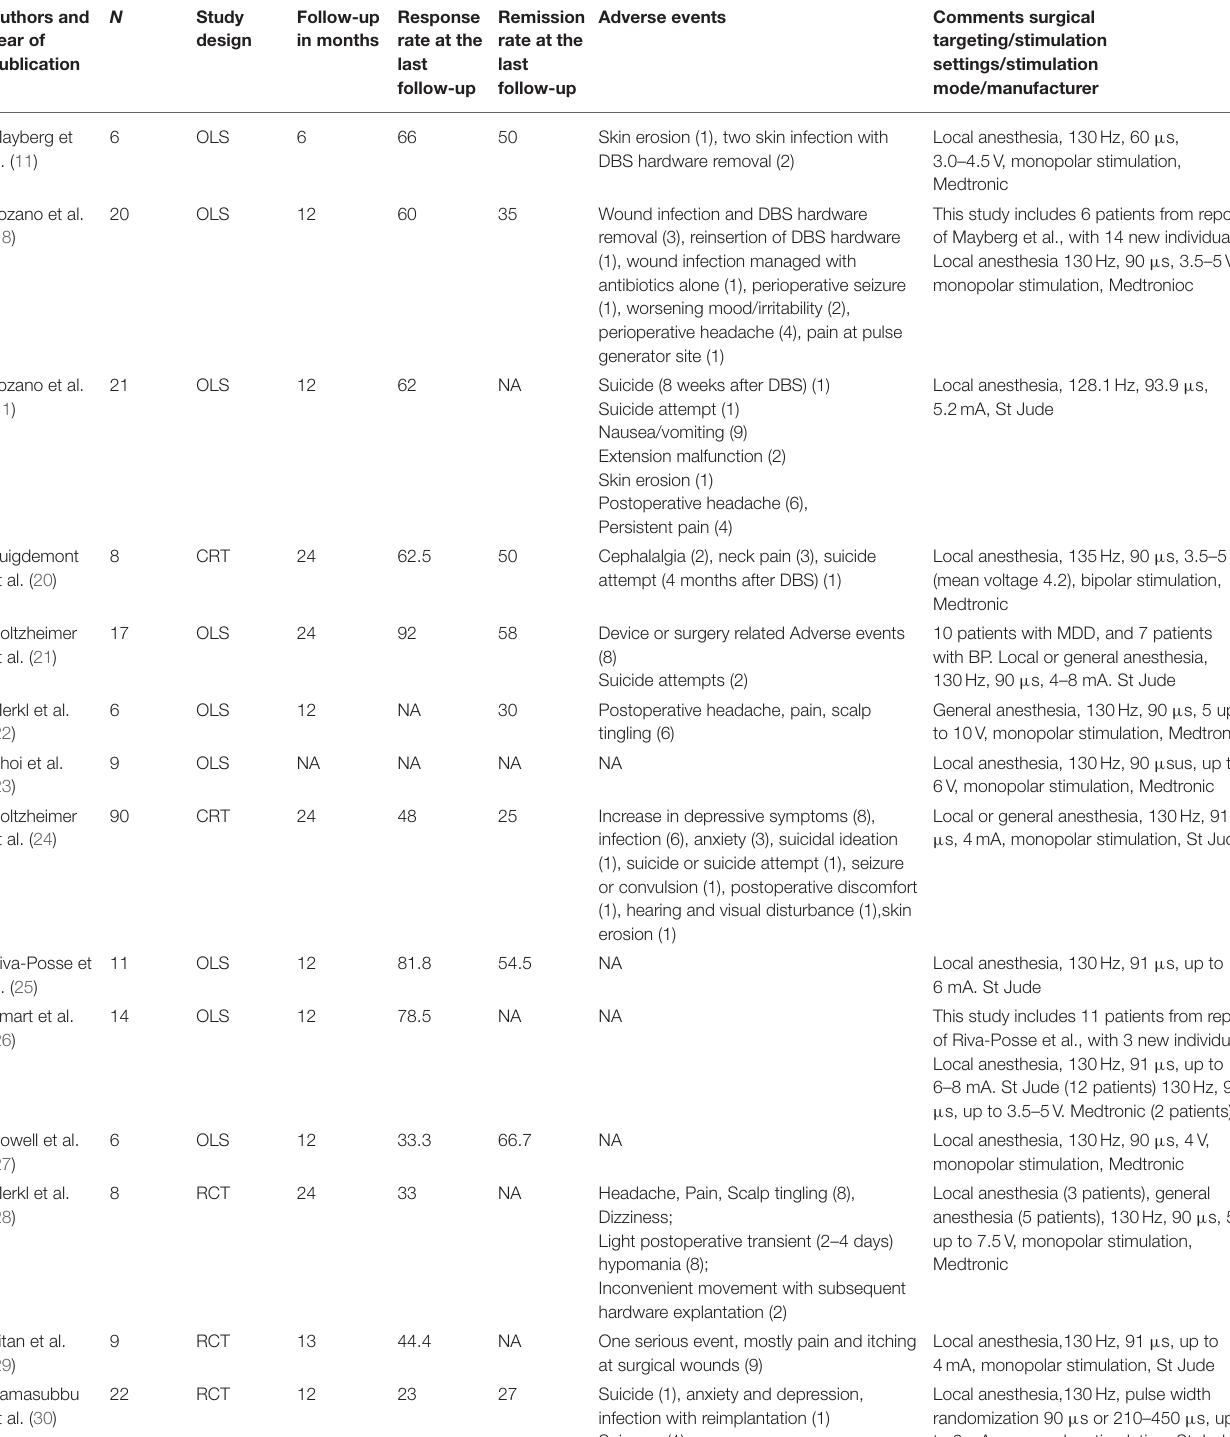
TABLE 1 | Open-label clinical trials and randomized clinical trials (RCTs) reporting subcallosal cingulate cortex (SCC) deep brain stimulation (DBS) outcomes for treatment-resistant depression